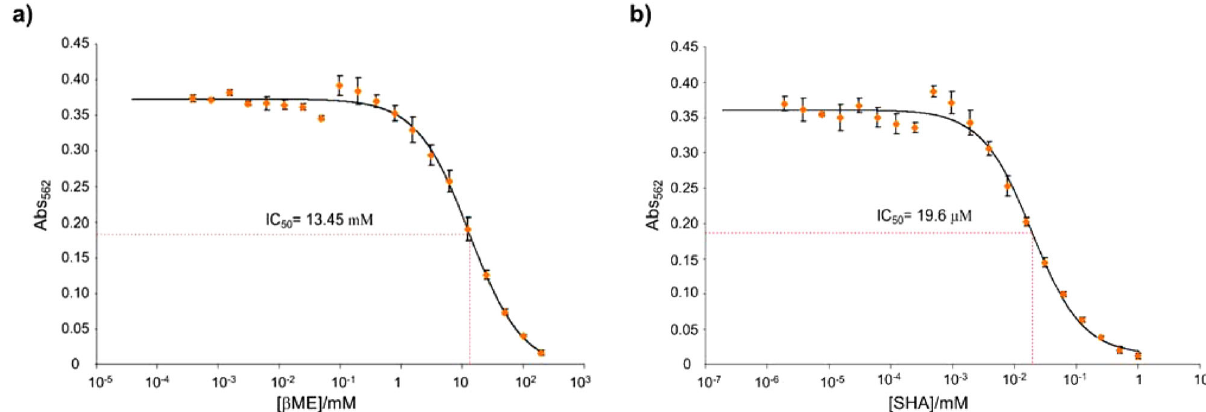
Fig. 3 In vitro inhibition of H. pylori urease by BME and SHA. Dose-response curves measuring pH increase due to ammonia generation as a function of inhibitor concentration using a phenol red spectrometric assay (absortion at 562 nm). a BME inhibition curve showing an IC 50 of 13.5 mM under the conditions (see “ Methods ” ). Using this value, a substrate (urea) concentration of 6 mM and the reported K m of H. pylori urease of 0.2 mM 29 , the Cheng- Prusoff equation 30 assuming competitive inhibition yields a K i of 435 μ M for BME. b SHA inhibition curve with an IC 50 of 19.6 μ M. The corresponding K i is